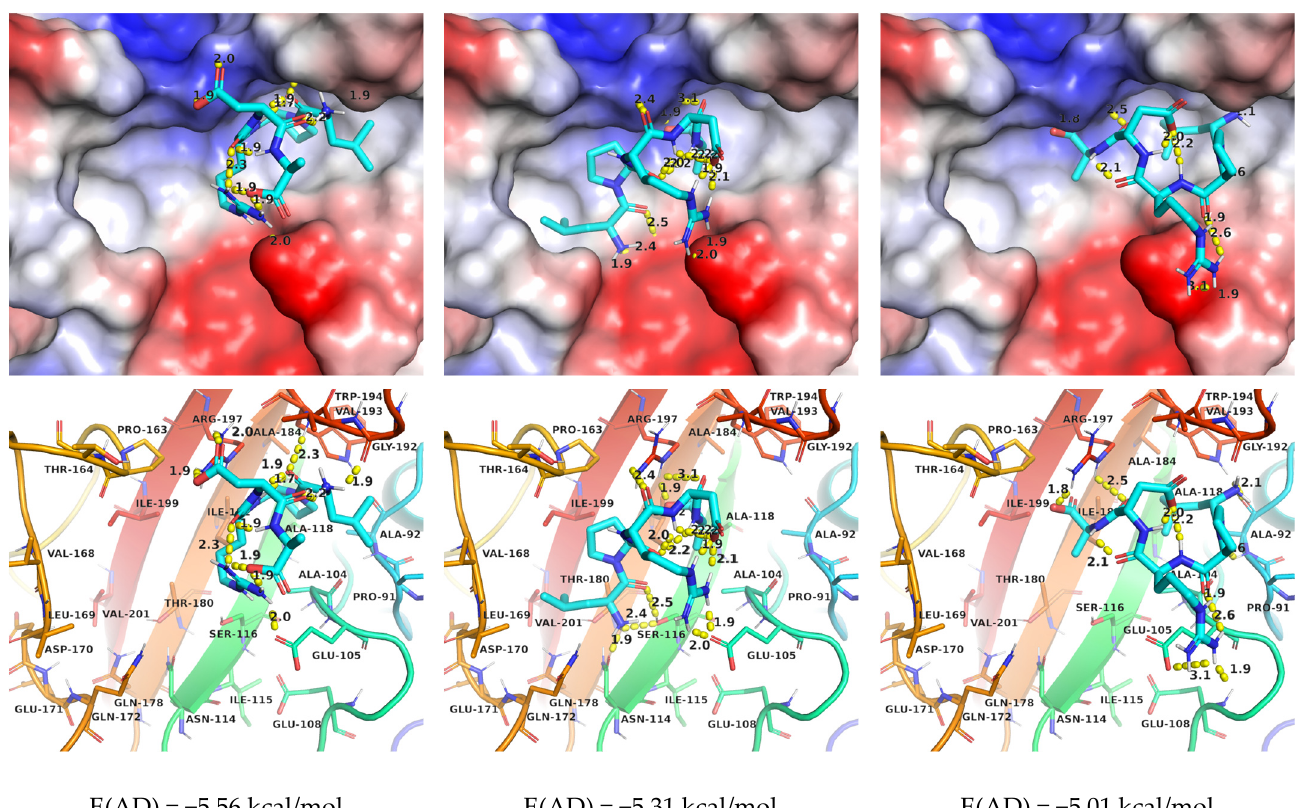
Figure 2 . The first three binding modes of LPRDA-StrA found by AutoDock using the default search parameters.